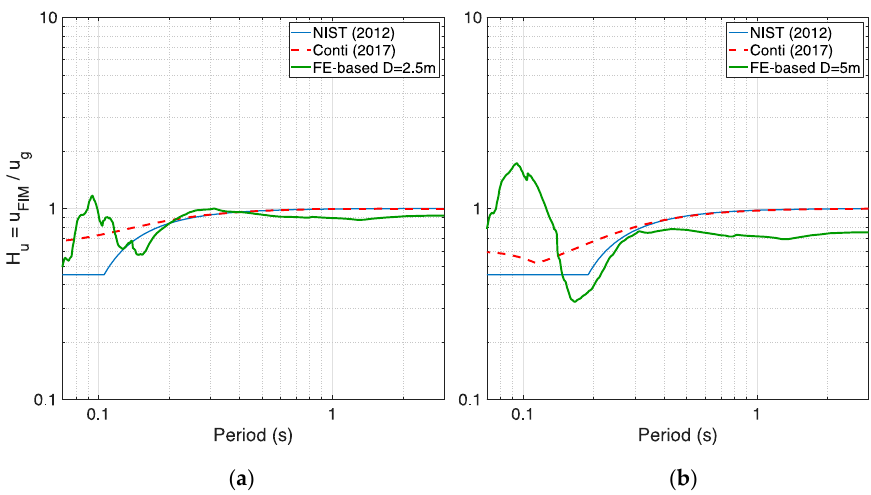
Figure 16. Comparison between analytical transfer functions obtained from two models and FE- based ones for embedment depths of ( a ) 2.5 m and ( b ) 5 m for BOWW soil profile and record “Accel borehole”.